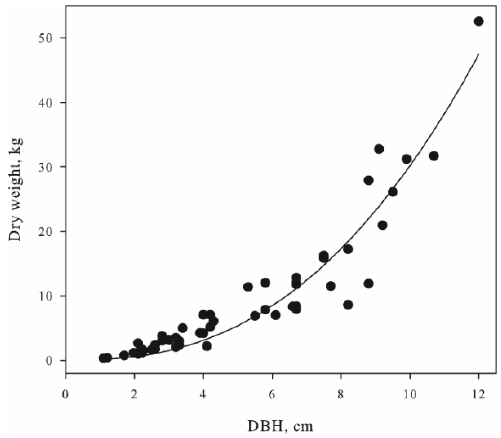
Figure 2. Relationship between total aboveground dry weight of understorey trees (DBH < 10 cm) and diameter at breast height (1.3 m) overbark fitted to nonlinear curve. DBH: diameter at breast